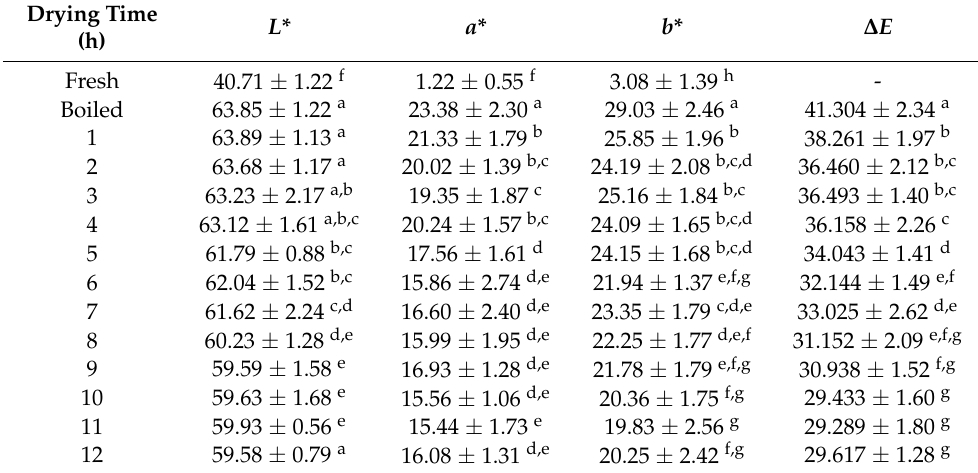
Table 2. Effects of hot air drying on the color of